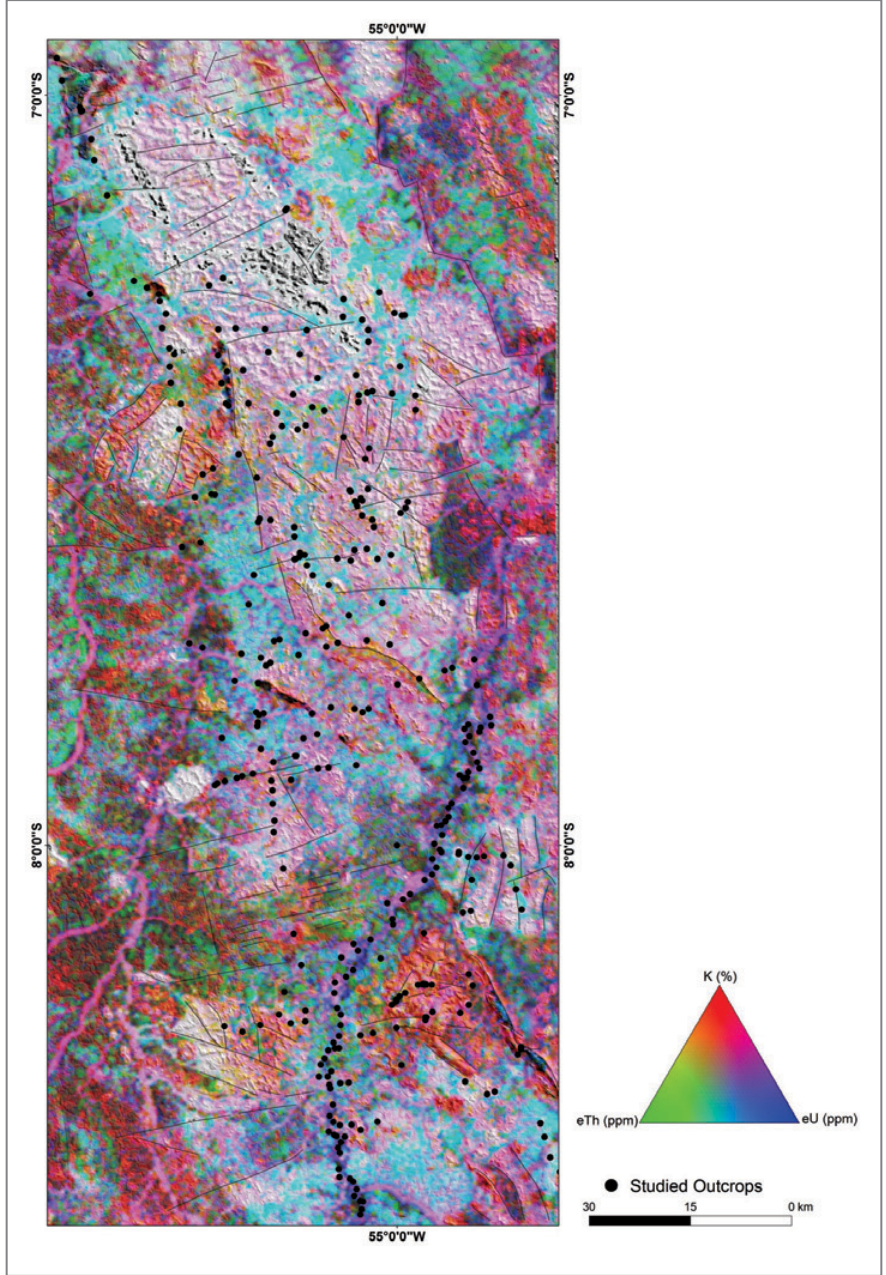
Figure 4 - Ternary composition of K, eTh e eU showing the interpreted radiometric